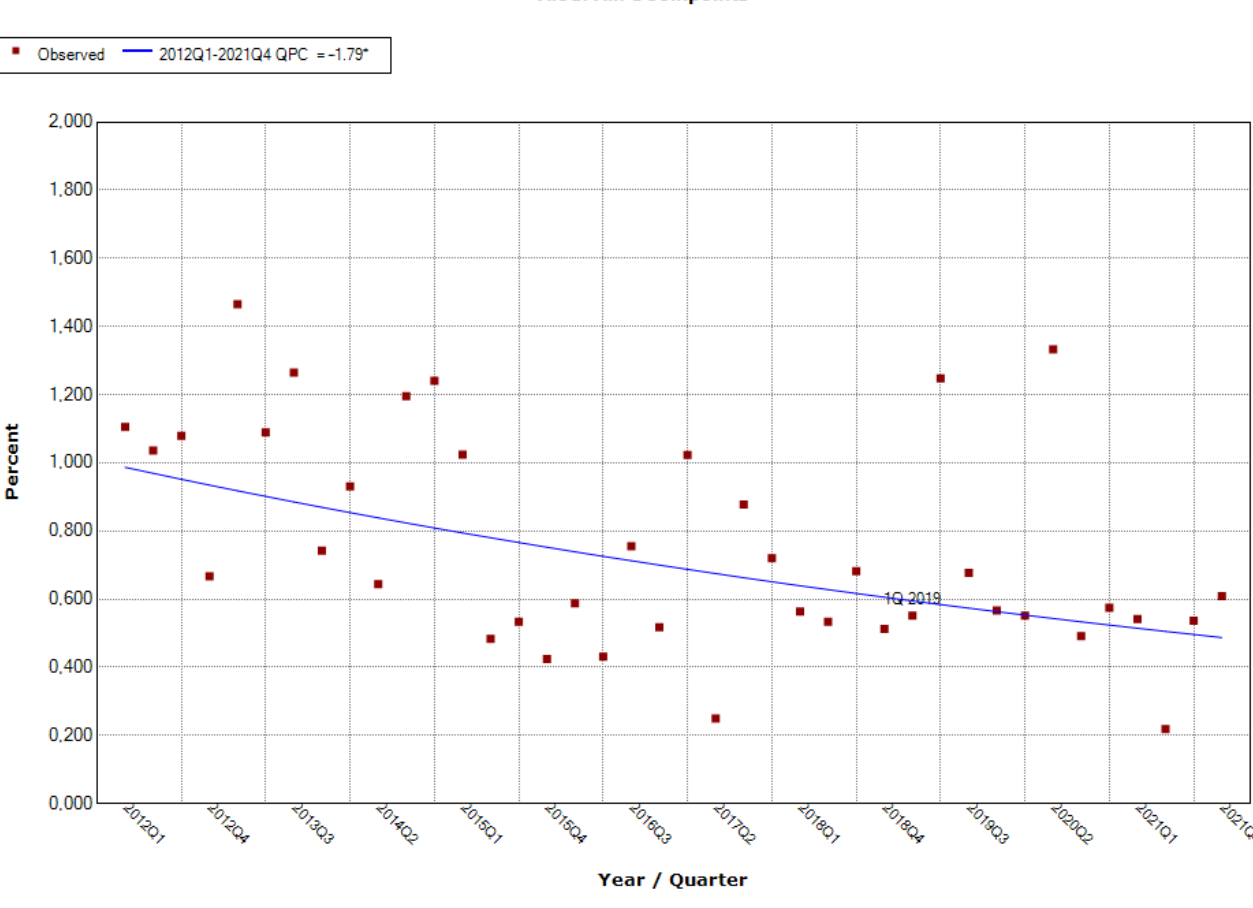
Figure A7. Percentage of products containing aloe in individual quarters in the period from 2012 to 28 November 2021. Joinpoints mark trend turning points. The date above the observation indicates the moment of publication of the scientific opinion/resolution.